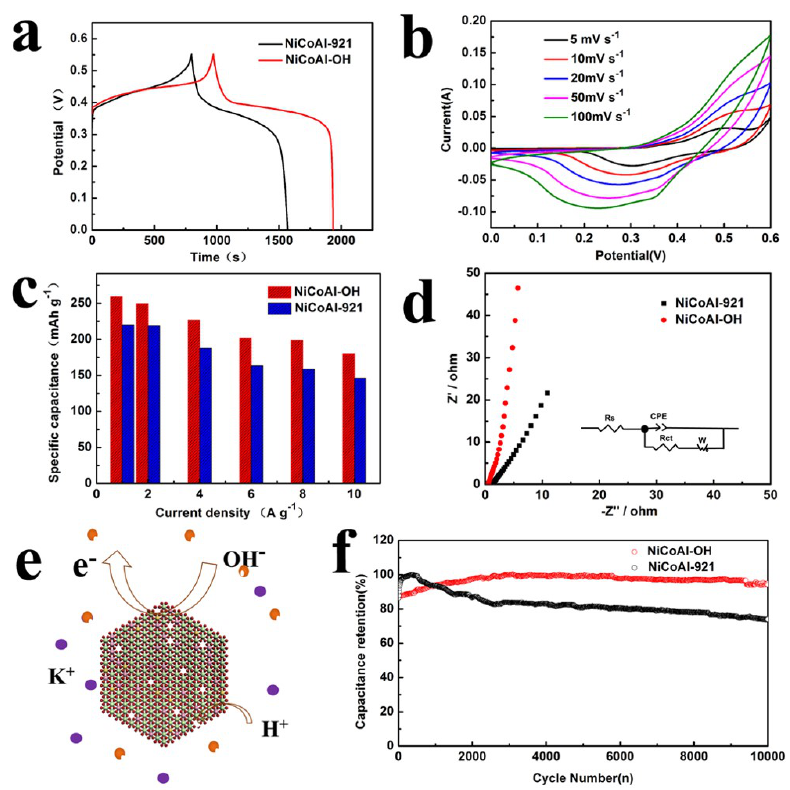
Figure 4. ( a ) Galvanostatic charge/discharge curves of the NiCoAl-LDH and NiCoAl-OH electrodes at a current density of 1 A g − 1 . ( b ) CV curves of the NiCoAl-OH electrodes at various scan rates of 5–100 mV s − 1 . ( c ) The specific capacity of the NiCoAl-LDH and NiCoAl-OH electrodes at different current densities. ( d ) Nyquist plots of NiCoAl-LDH and NiCoAl-OH electrodes. ( e ) Schematic illustration of the charge storage mechanism of NiCoAl-OH electrodes. ( f ) Cycling performance at 5 A g − 1 of NiCoAl-LDH and NiCoAl-OH electrodes in 6 M